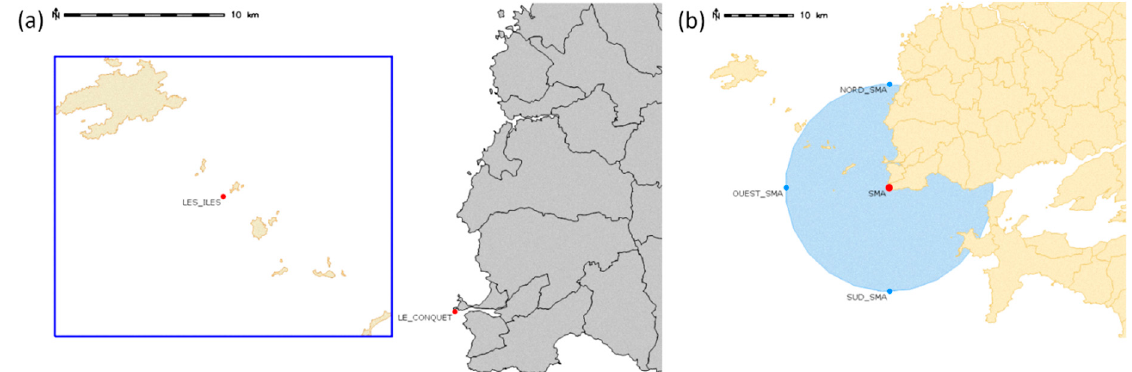
Figure 6. The semantic uncertainties in gate placement. ( a ): the placement of gates related to a zone ( left ) and a port ( right ); ( b ): the placement of gates related to a direction with respect to the Saint-Mathieu sémaphore (the mean visibility considered is 15 km).